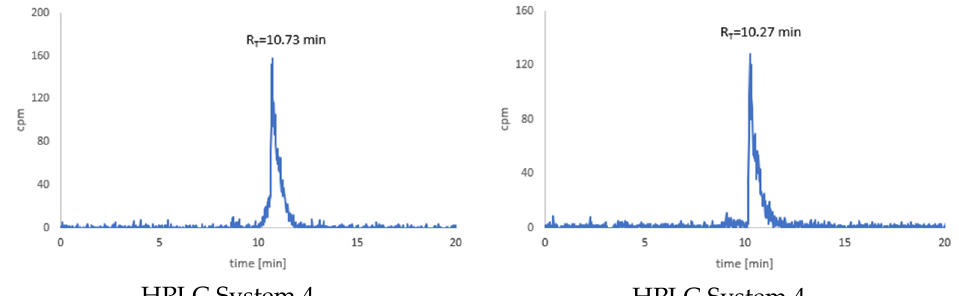
Figure 7. RP-HPLC radiochromatograms (System 4) of the stability studies of the 177 Lu-2 radioconju- gate in Cys ( left , RCP 98.3 ± 2.5%, n = 3) and His ( right , RCP 98.3 ± 2.8%, n = 3) solutions recorded after 6